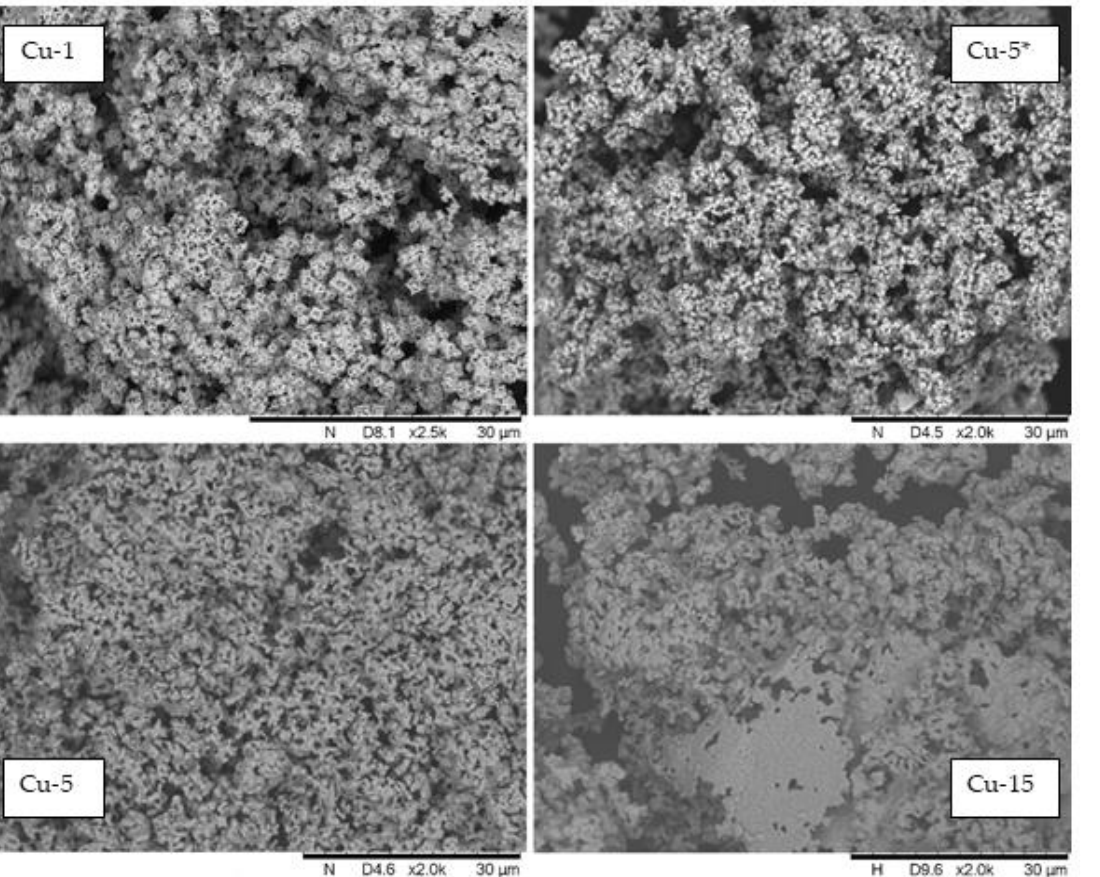
Figure 10. The HRTEM microphotographs of the copper catalysts (Cu-1, Cu-5*) generated in situ in the reaction medium during hydrogenolysis of glycerol.